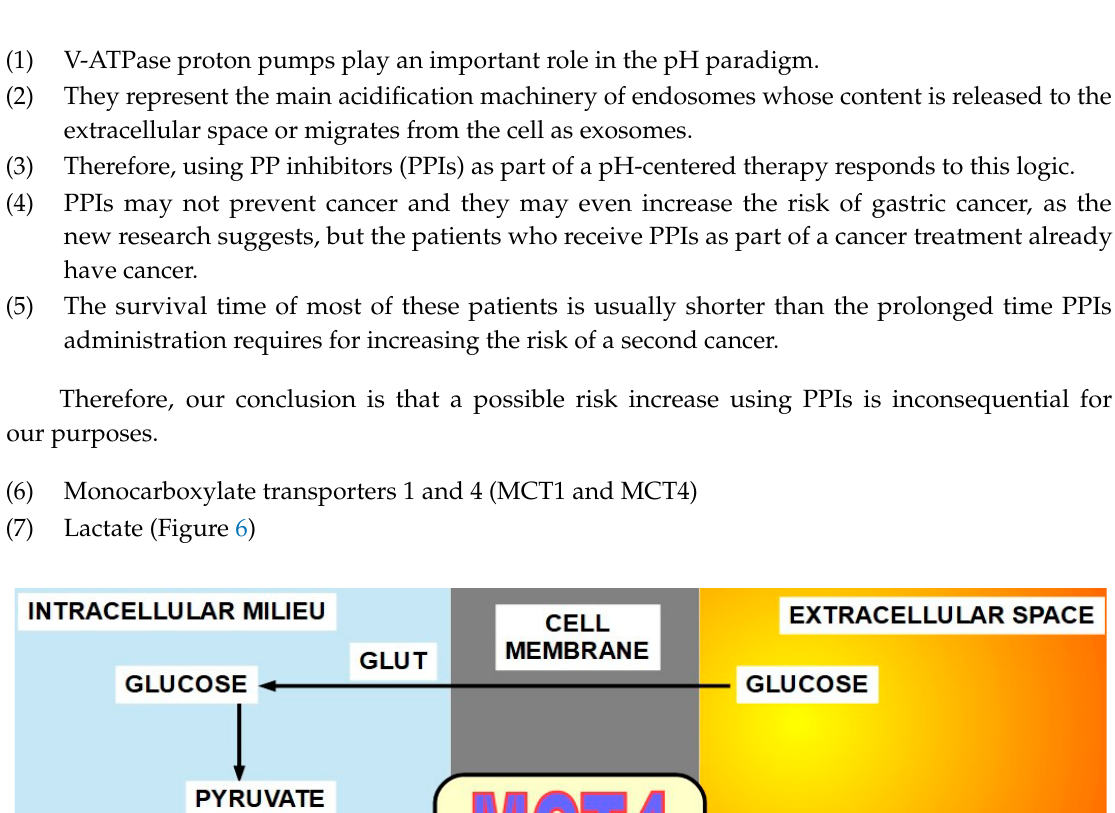
Figure 5. V-ATPase proton pump mechanism of action.